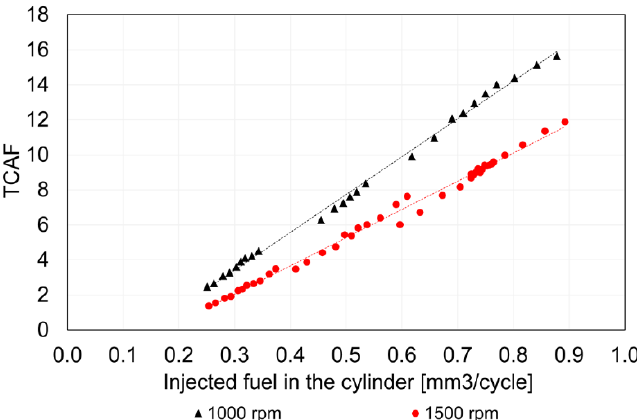
Figure 16. Correlation between the TCAF and the injected fuel quantity in the cylinder at 1000 and 1500 rpm from low load to full load.